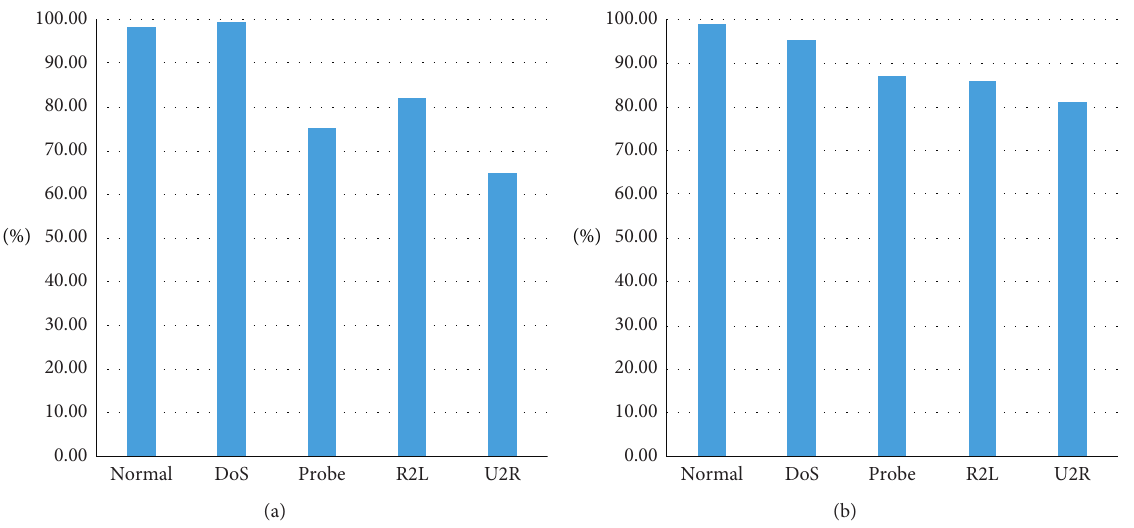
Figure 8: Detection rate for each class in the dataset. (a) KDD-CUP 99. (b) NSL-KDD.